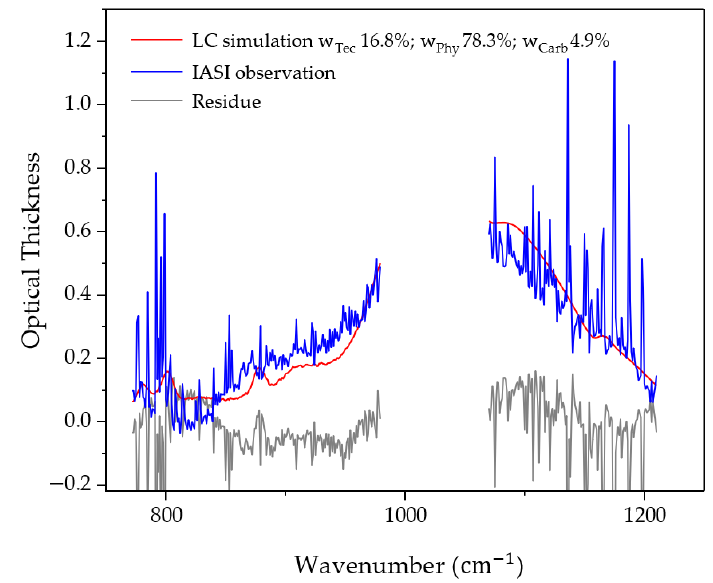
Figure 13. Simulation of the linear combination of pure mineral coefficients (red) fitted with the IASI dust optical thickness (blue) with the remaining residue from the simulation and experimental spectrum (gray) and the RMS (light gray envelope).